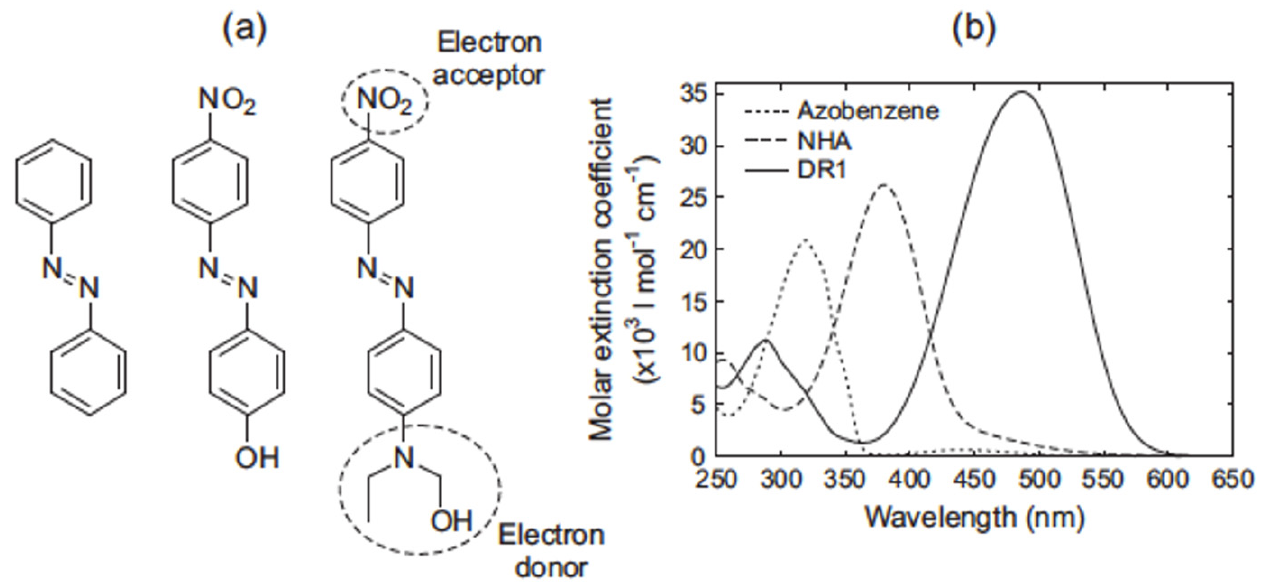
Figure 6. ( a ) Examples of azobenzene molecules of azobenzene-type (unsubstituted azobenzene, left) aminoazobenzene- type (4-nitro-4 ′ -hydroxyazobenzene (NHA), center), and pseudostilbene-type (Disperse Red 1 (DR1), right). ( b ) Absorption spectra of azobenzene, NHA, and DR1 in 2 × 10 − 5 mol/L tetrahydrofuran solution [71].